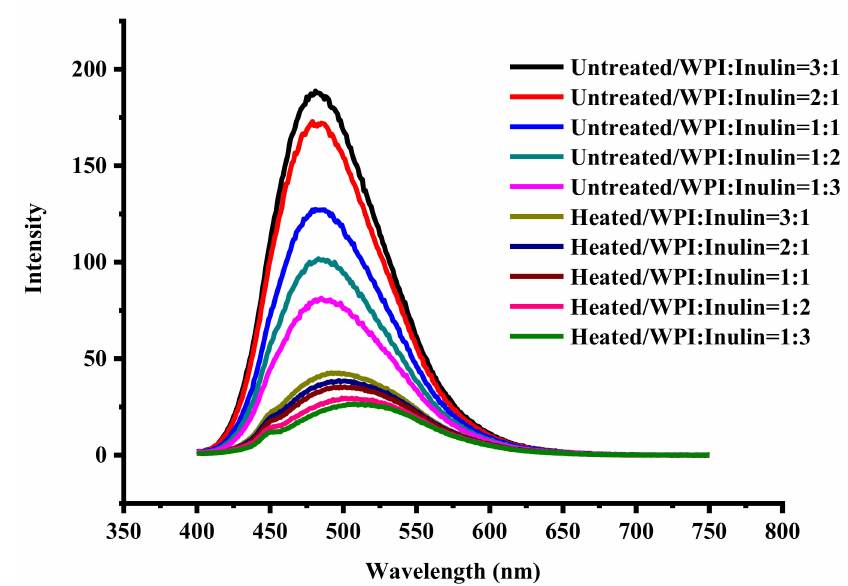
Figure 4. Surface hydrophobicity of whey protein and inulin mixture before and after dry